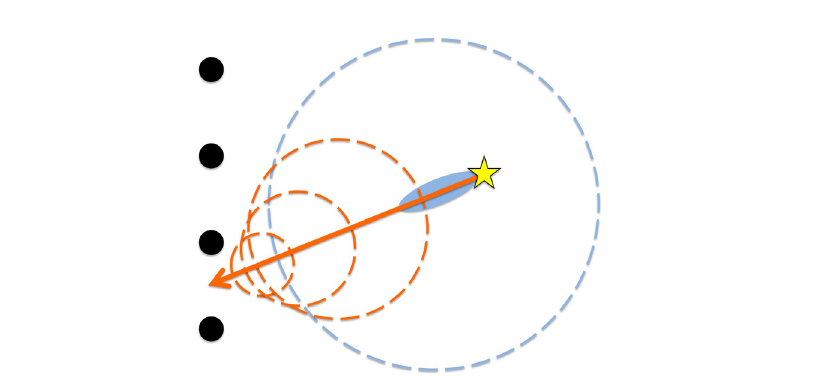
Figure 3. Relative contribution to the sensitivity to the galactic plane using ANTARES tracks (red), Figure 4. In hadronic showers with an early muon, the earliest light in some DOMs is from the muonic ANTARES showers (orange) and IceCube tracks (green) as a function of declination. component, because the muons travel faster than the speed of light in ice. Here Cherenkov light pro- duced by the muon is shown in orange, while earliest light by the cascade is in top 0.3% brightest blazars detected by Fermi. Fig. 2 shows the alert IceCube-170922A with Fermi and MAGIC data.